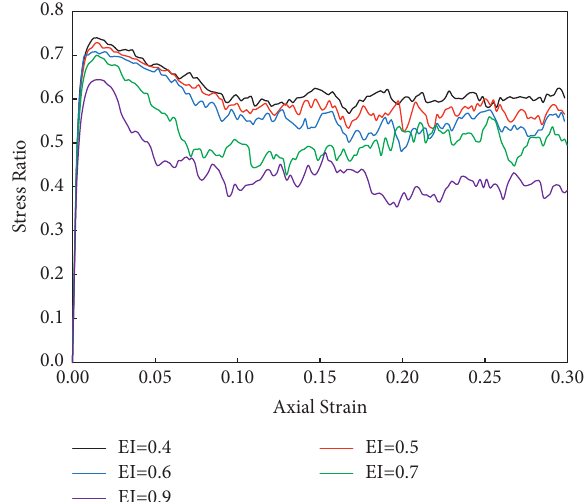
Figure 17: The evolution of stress ratio versus axial